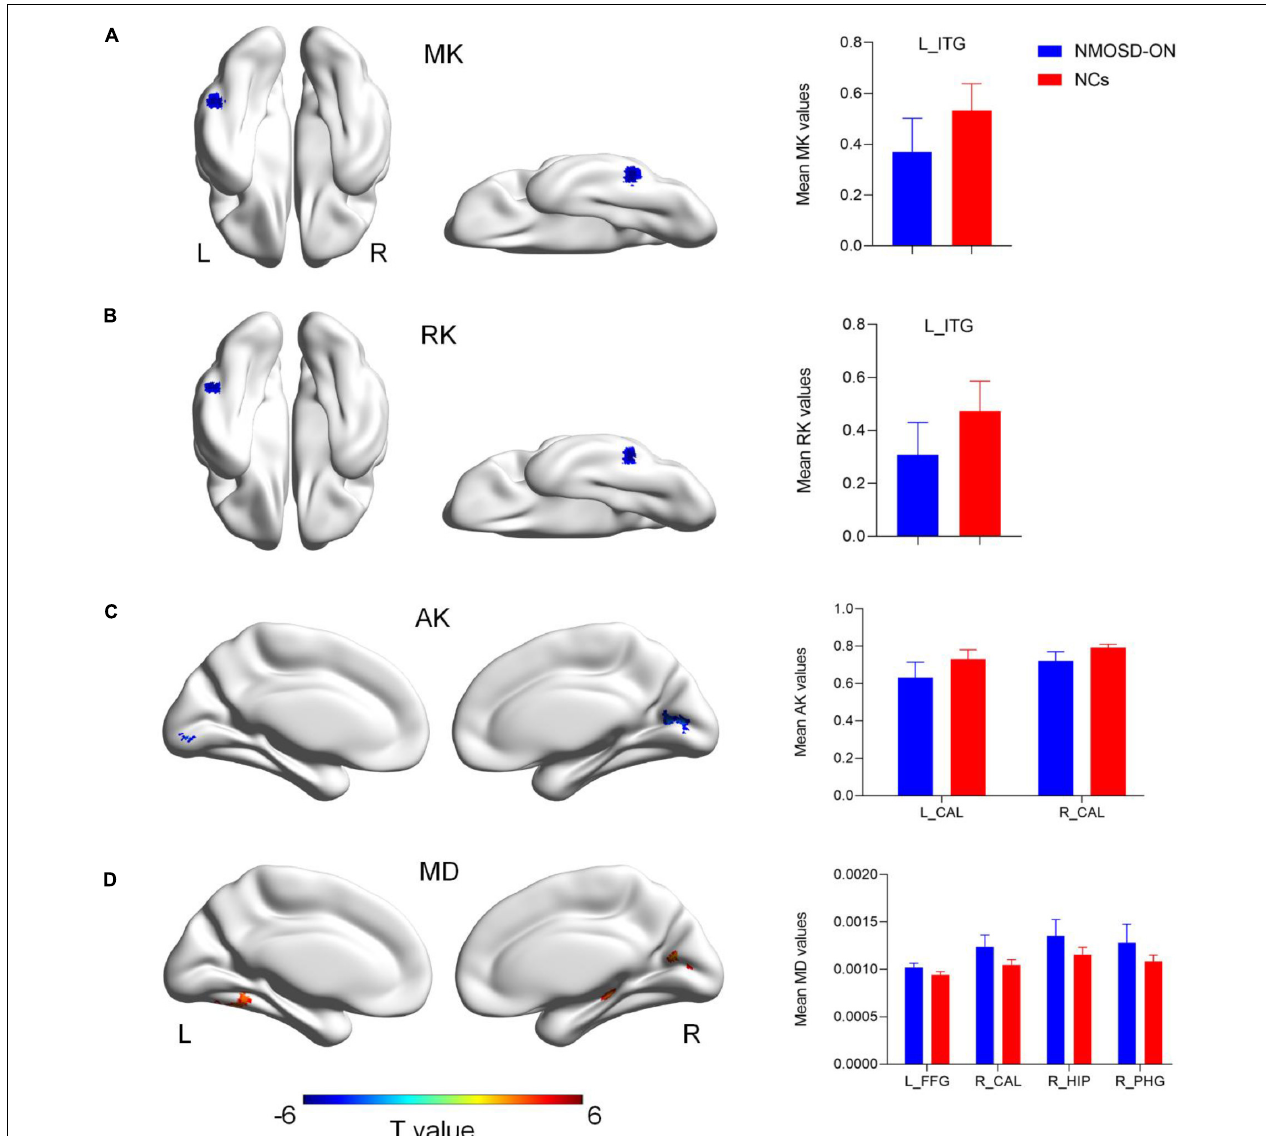
FIGURE 1 | Diffusion kurtosis imaging metrics differences between the two groups (uncorrected voxel p < 0.001, corrected cluster p < 0.05, GRF corrected). (A) Compared with normal controls (NCs), NMOSD-ON patients showed decreased MK values in the left inferior temporal gyrus (ITG). (B) Decreased RK values were also observed in the left ITG. (C) Decreased AK values were observed in the bilateral calcarine (CAL). (D) Increased MD values were observed in the left fusiform gyrus (FFG), right CAL, right hippocampus (HIP)/parahippocampal gyrus (PHG). The details of the regions were shown in Table 2 . NMOSD-ON, neuromyelitis optica spectrum disorder-optic neuritis; NCs, Normal controls; MK, mean kurtosis; RK, radial kurtosis; AK, axial kurtosis; MD, mean diffusivity; ITG, inferior temporal gyrus; CAL, calcarine; FFG, fusiform gyrus; HIP, hippocampus; PHG, parahippocampal gyrus; GRF, gaussian random field; L, left; R,